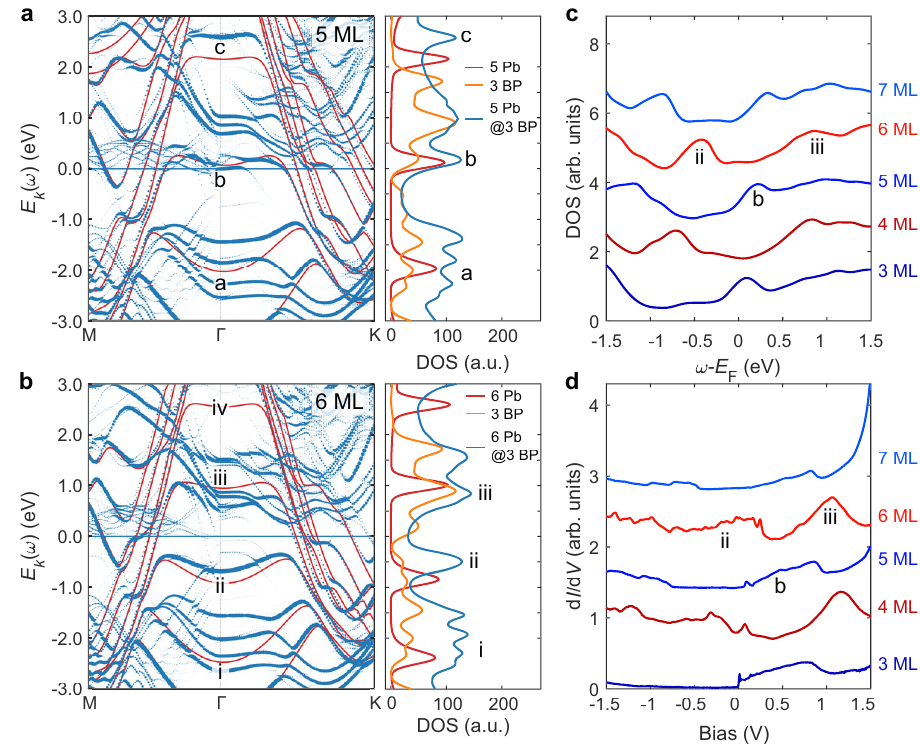
Fig. 4 Electronic structure calculations of the hybrid structure and comparison to the experimental LDOS. a , b Unfolded band structures for 5 ML ( a ) and 6 ML ( b ) Pb on 3 ML BP. These are plotted along high-symmetry points of the primitive Pb (111) unit cell. Solid red lines in the band structures refer to the pristine (but strained) 5 ML and 6 ML Pb band structure. Blue dots correspond to the unfolded spectral function as de fi ned in Eq.(4) in the Supplementary Note 2, where the dot-size represents the intensity of A ( k , w ) at the corresponding momentum and energy. The side panels of a and b show the quasi-local spectral functions ρ ω ð Þ using a smearing σ k = 0.01. Blue lines represent unfolded heterostructure data, while the red and orange lines depict ρ ω ð Þ for the pristine Pb and BP structures, respectively. c Calculated spectra for Pb/BP heterostructures with various thicknesses of Pb fi lms from 3 ML (bottom) to 7 ML (top). Films with an even (odd) number of MLs are color coded with red (blue) shades. Spectra are shifted vertically for clarity. d d I /d V spectra measured in wide bias range on Pb fi lms with thickness from 3 ML (bottom) to 7 ML (top) grown on BP. Spectra are shown with color shades corresponding to the spectra in c ( V stab = 1.5 V, I stab = 500 pA, V mod = 5 mV, T = 35